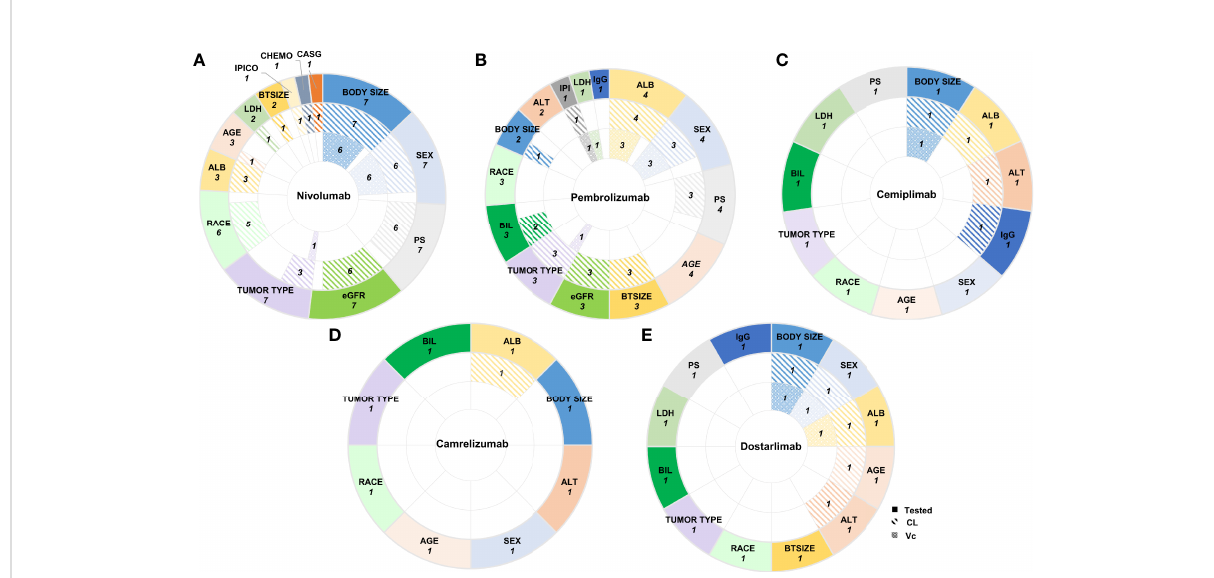
FIGURE 2 The number of PPK analyses in which covariates were tested and included in the fi nal models. The pie charts showed the number of PPK analyses in which covariates were tested, included in the fi nal models affecting CL or V C (from outermost to innermost ring) of (A) Nivolumab, (B) Pembrolizumab, (C) Cemiplimab, (D) Camrelizumab, and (E) Dostarlimab. Tested Covariates for each anti-PD-1 mAbs shown here were those included in more than one fi nal PPK models. CL, clearance; V C , volume of the central compartment; CASG, with prior gastrectomy; CHEMO, chemotherapy; IPICO, ipililumab coadministration; BTSIZE, baseline tumor size described by the sum of long diameters of target tumor lesions; LDH, lactate dehydrogenase; ALB, albumin; eGFR, estimated glomerular fi ltration rate; PS, performance status; IgG immunoglobulin